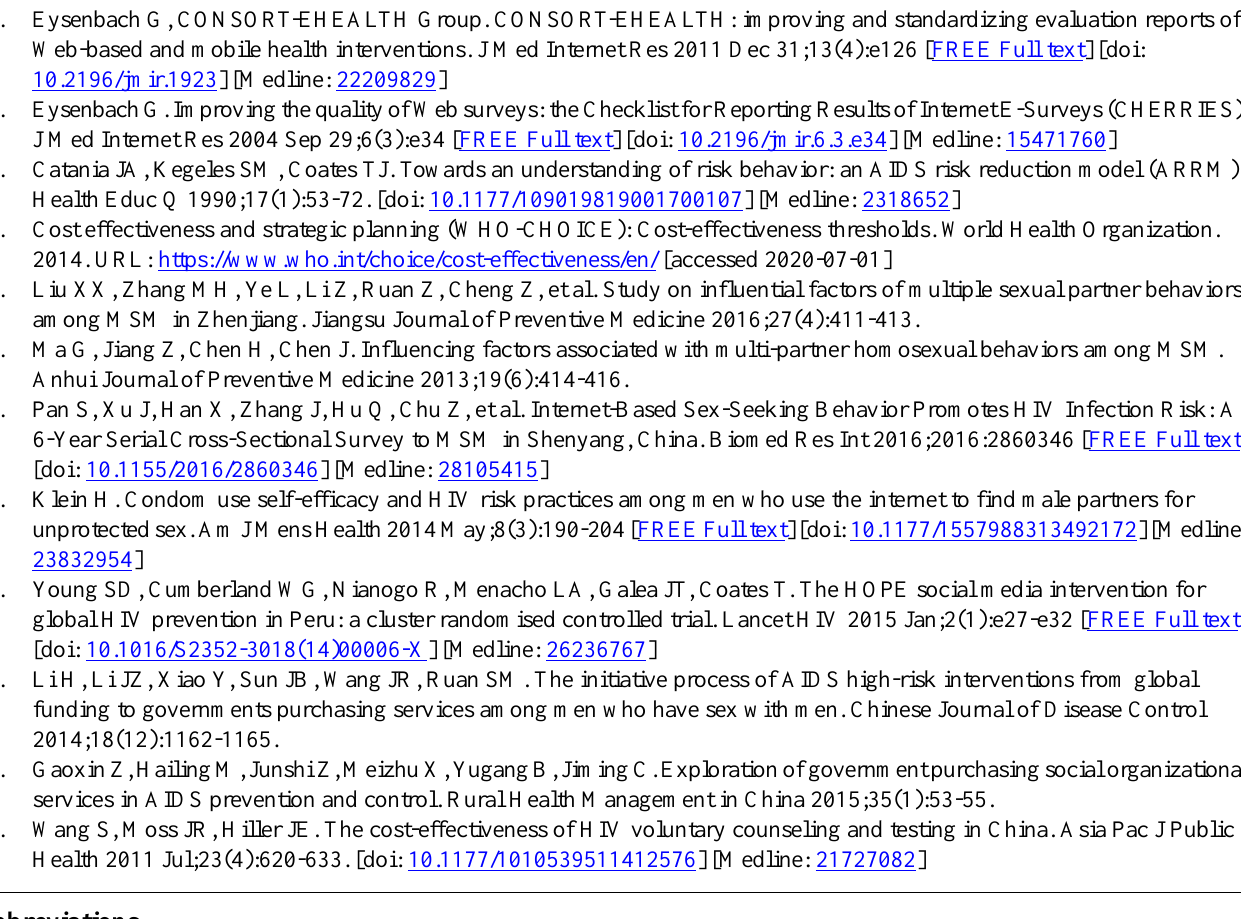
Abbreviations CBO: community-based-organization CER: cost-effectiveness ratio ICER: incremental cost-effectiveness